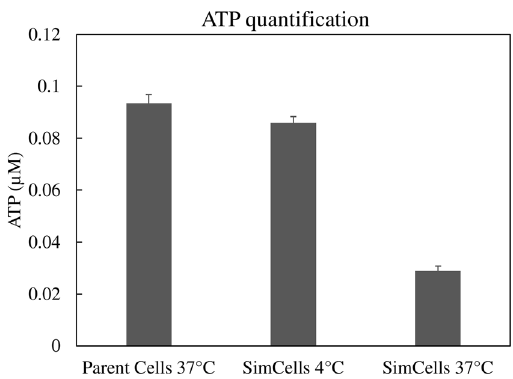
Figure 5. Total ATP from 100 µ L SimCells with pCdaR (OD600 = ~0.1) using a luciferase based assay kit, BacTiterGlo. Samples included: non-purified parent cells maintained at 37 °Cand purified SimCells maintained for 24 h at 4 °C and at 37 °C, to demonstrate the temperature dependency of the ATP concentration. Error bars represent one standard deviation above and below the mean (n =